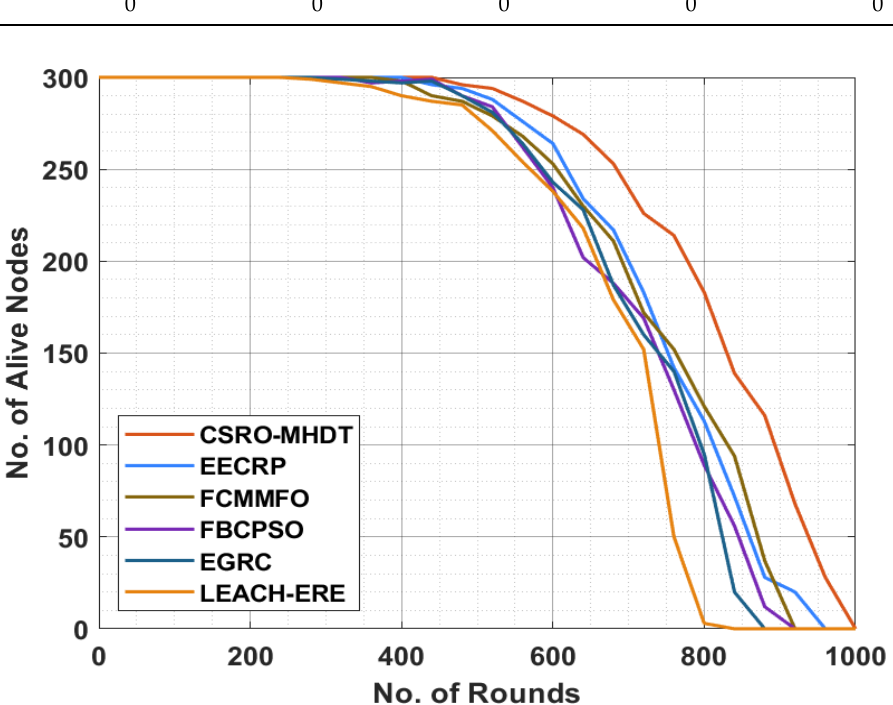
Figure 3. NAN analysis of the CSRO-MHDT technique in comparison with existing approaches.